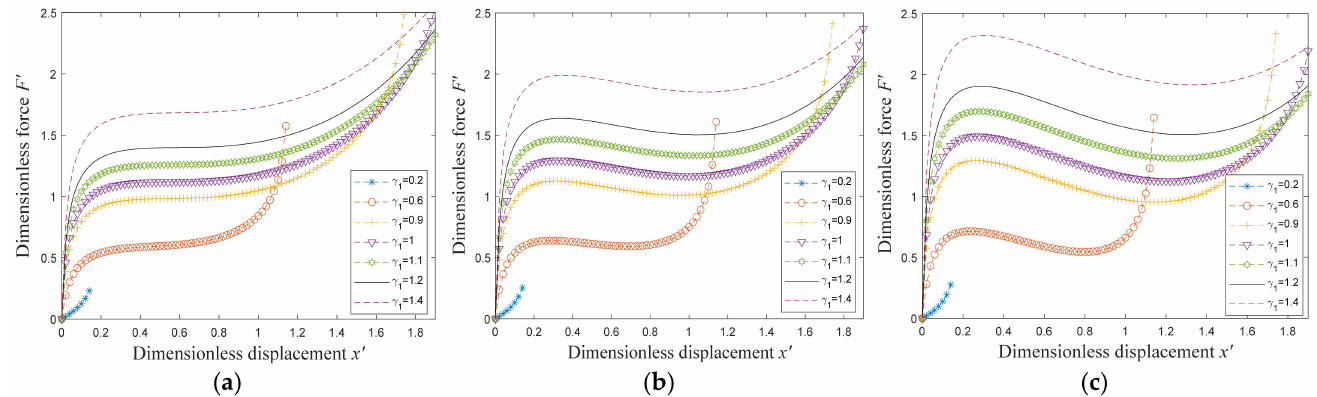
Figure 4. Dimensionless force–deflection curves with the various values of γ 1 : ( a ) α = 0.8, γ 2 = 1.2; ( b ) α = 1.0, γ 2 = 1.2; ( c ) α = 1.2, γ 2 = 1.2.